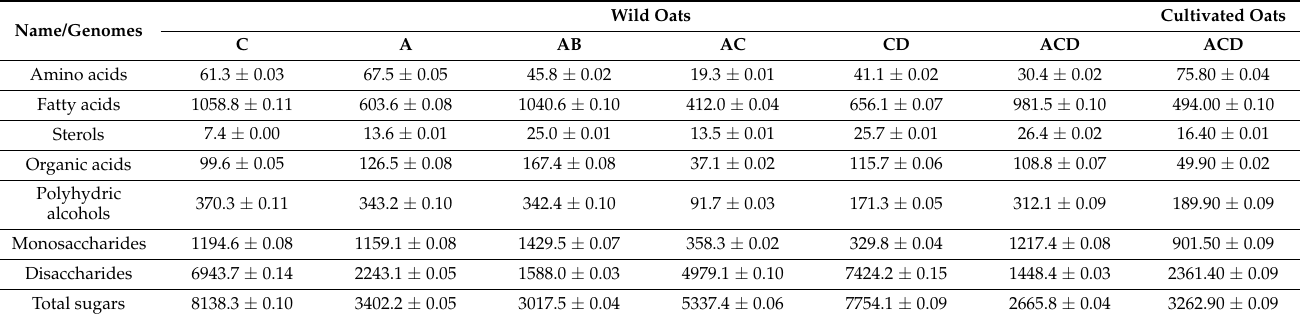
Table 4. Biochemical characteristics of caryopsis of wild and cultivated oats with different genomes (mg/100 g)